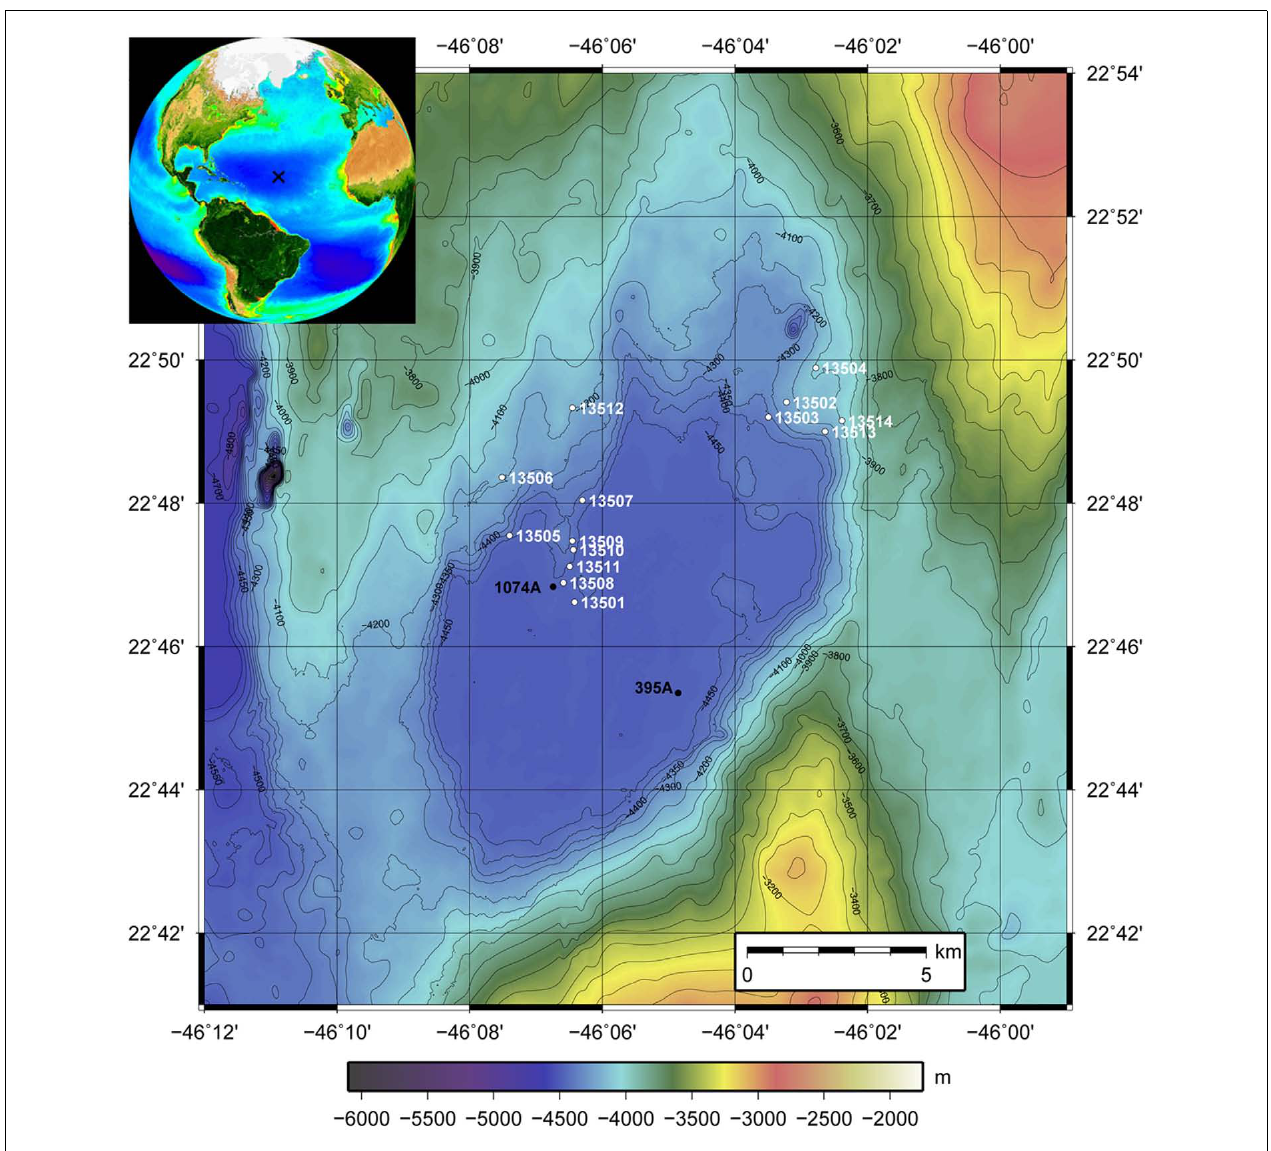
at shallower depths on the edges of the pond where sediment thicknesses are reduced.The inset shows the situation of North Pond in the Atlantic Ocean (generated on oceancolor.gsfc.nasa.gov/